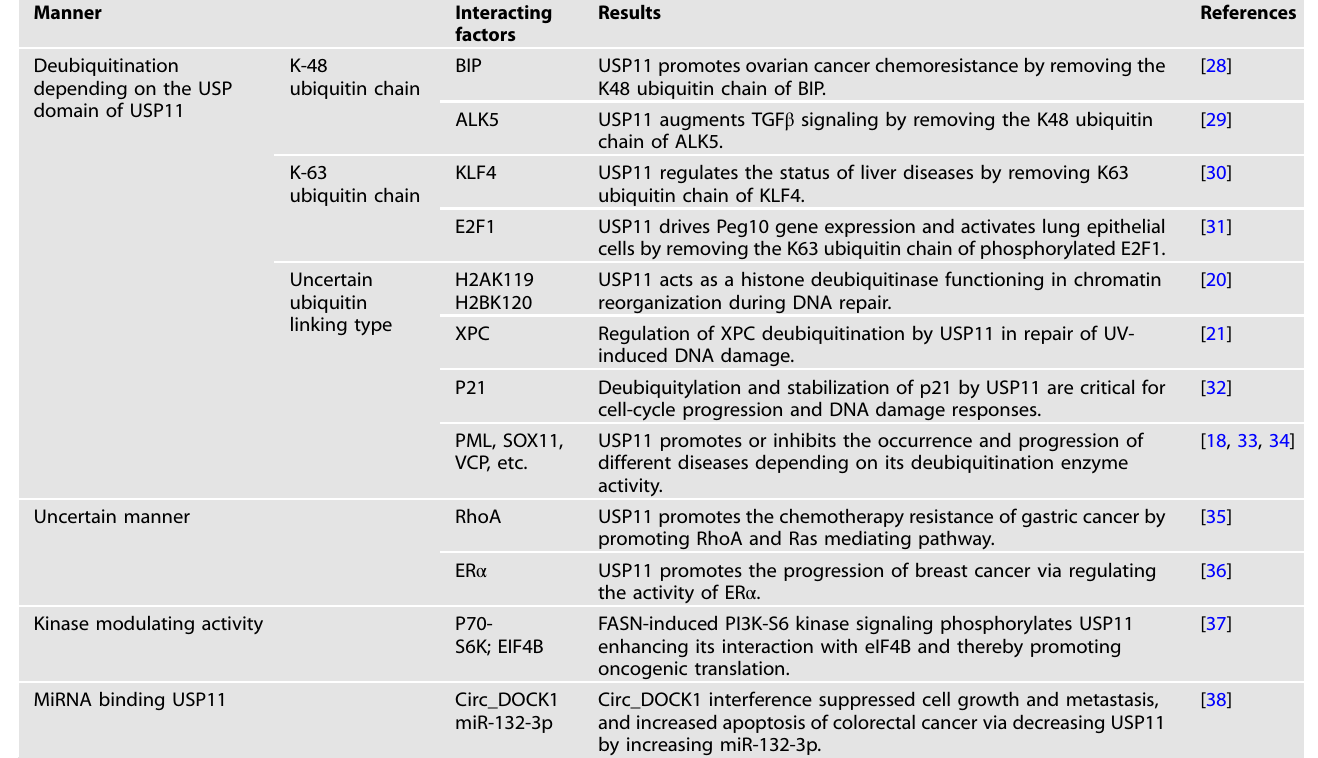
Table 1. The different manners of USP11 in pathophysiological conditions. Manner Interacting